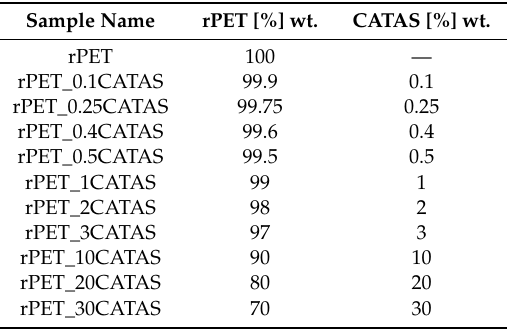
Table 1. Developed formulations based on rPET and